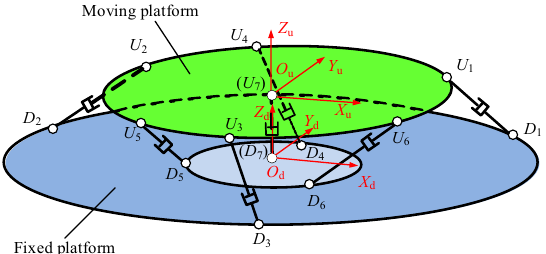
Figure 5 The 7-SPS active overconstrained